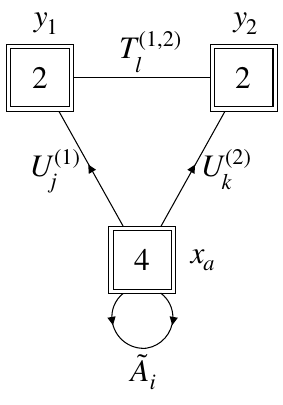
Figure 6 . Quiver of the dual WZ theory for N = 2